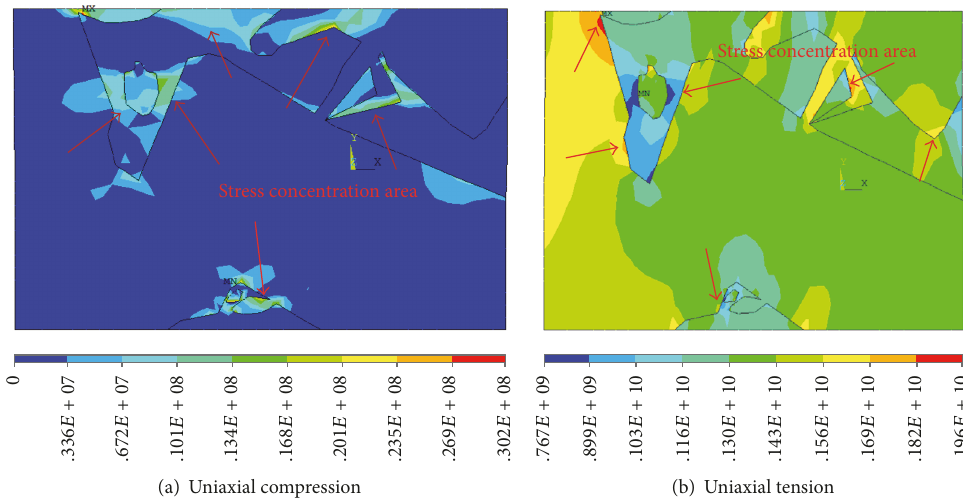
Figure 7: The distribution nephograms of the first principal stress inside the kernstone under uniaxial simulations.